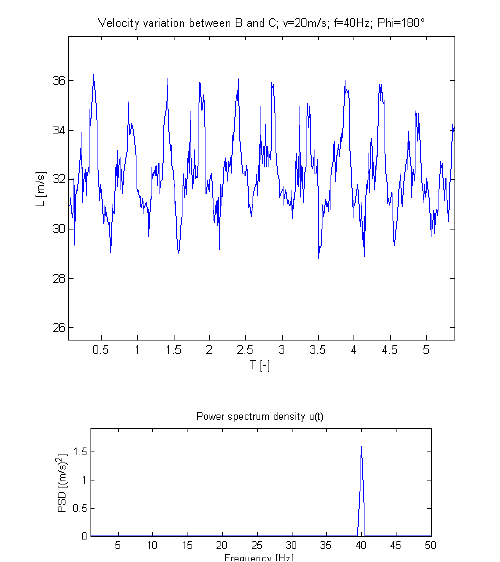
Fig. 7. Velocity variation and freq. spectra for one vel. component at point X for excited blades (turbine) .